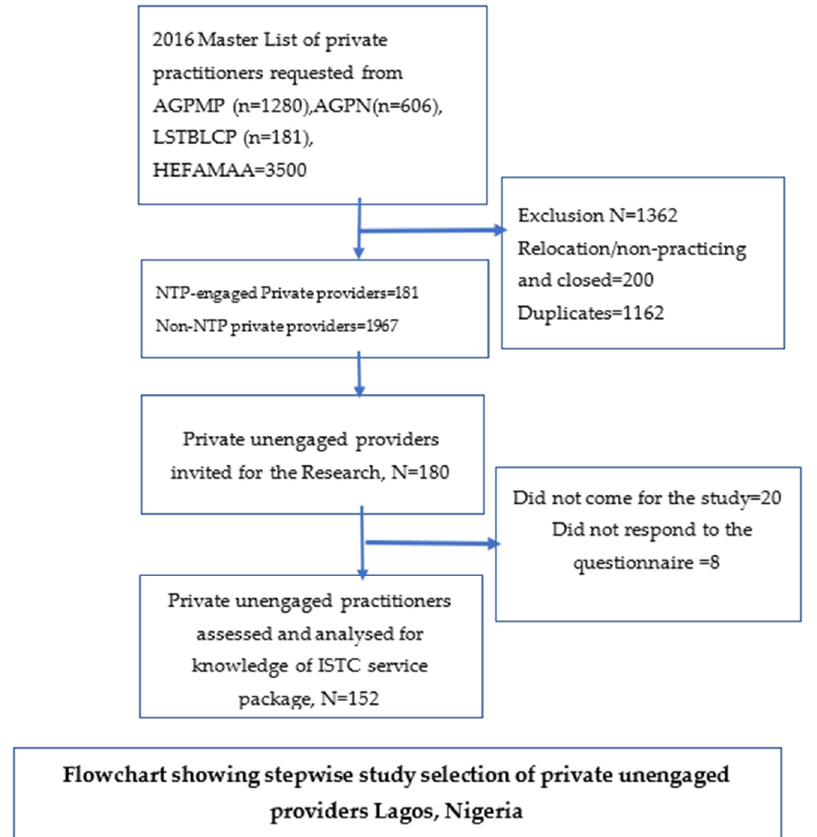
Figure 1. Flowchart showing stepwise study selection of private unengaged providers Lagos, Nige- ria. HEFAMAA—Health Facility Monitoring and Accreditation Agency, AGPMPN—Association of